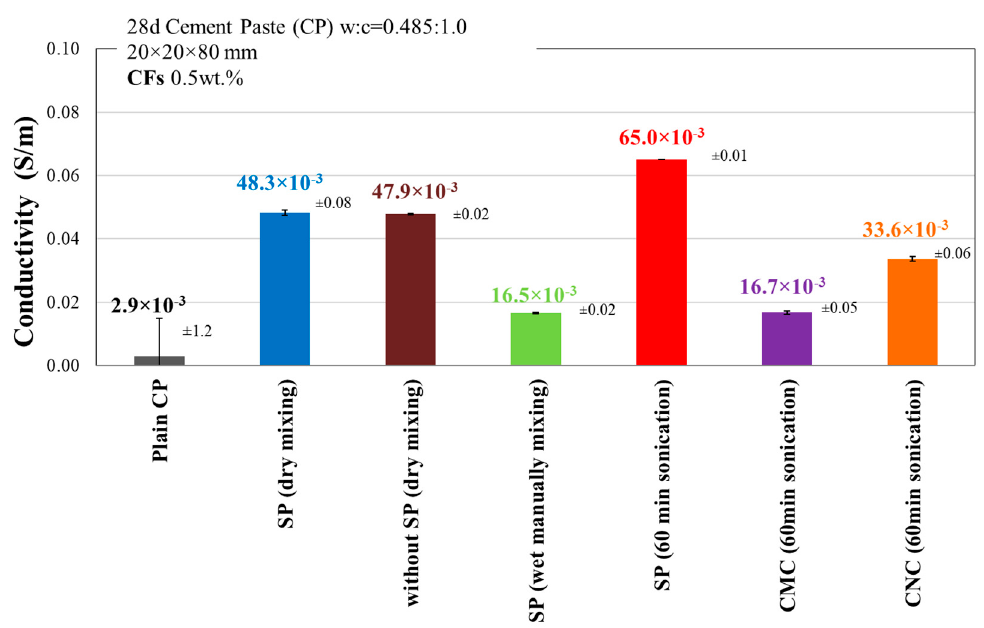
Figure 8. Conductivity values of 28-day plain cement pastes and cementitious CFs reinforced composites reinforced incorporated by different methods.